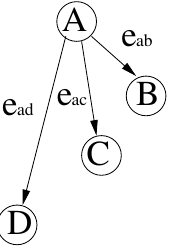
Figure 3. Node A and its neighbours with the respective edgeweights. From node A, the distance to node D > the distance to node C > the distance to node B and hence, e assuming all the nodes have the same stored